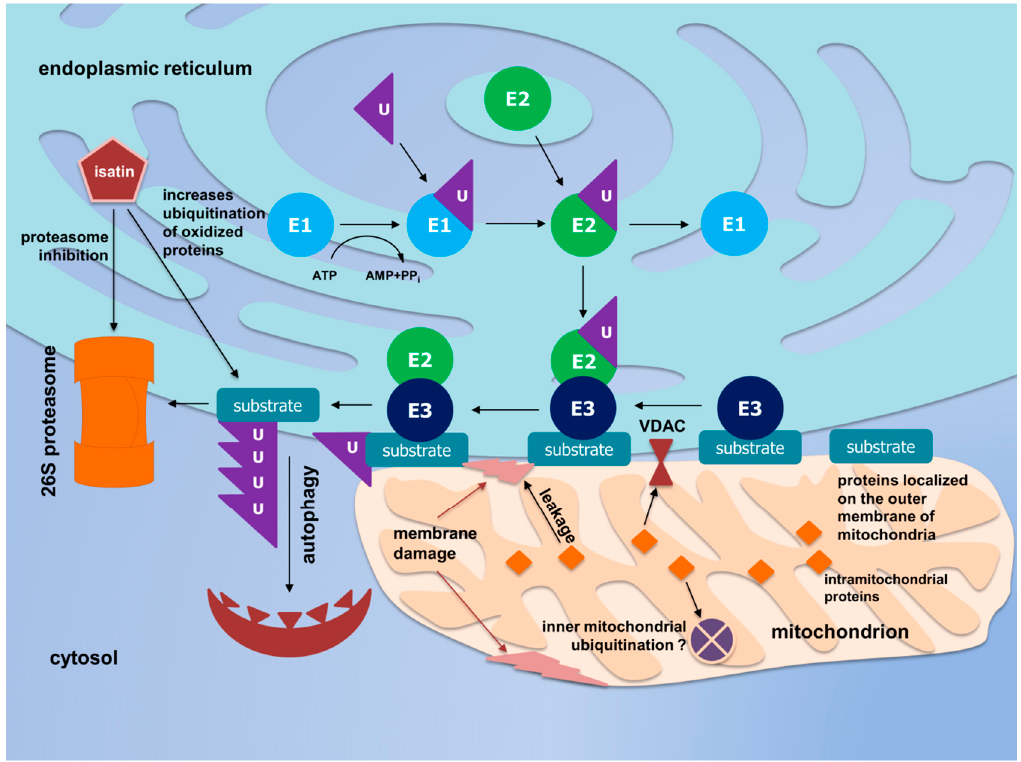
Figure 4. The scheme illustrating the proposed mechanism of neuroprotector action of isatin on metabolic routes of ubiquitinated proteins under conditions of MPTP-induced neurotoxicity. Isatin increases the ubiquitination of oxidized proteins associated with mitochondria, restricts binding of the proteins to the 26S proteasome ubiquitin receptor (Rpn10) and, thus, restricts the access of ubiquitinated proteins to the proteasome and shifts the flux of oxidized and ubiquitinated proteins to autophagy routes.